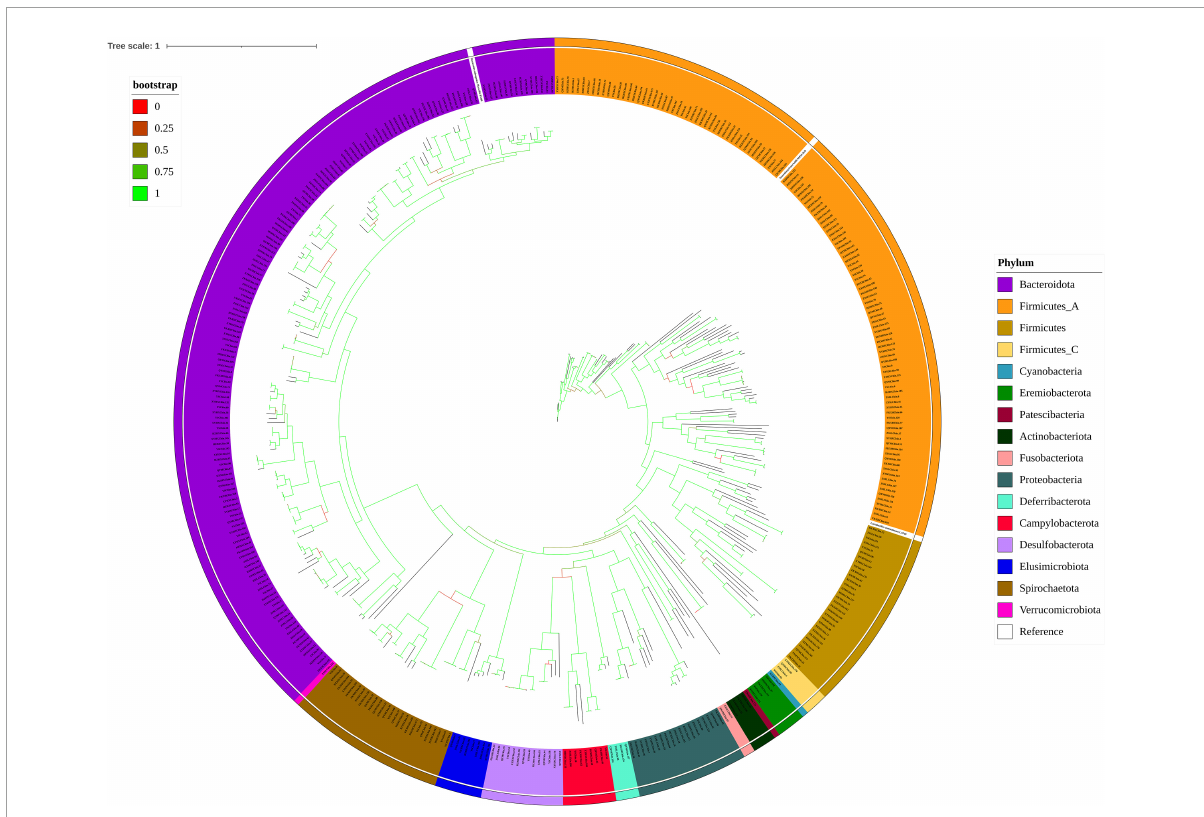
FIGURE7 Phylogenetic tree of the 404 draft bacterial genomes from the Chinese indigenous yellow-feathered chicken caeca and three reference genomes. The taxonomies of the bins were assigned by GTDB-Tk. The different coloured ranges represent the different